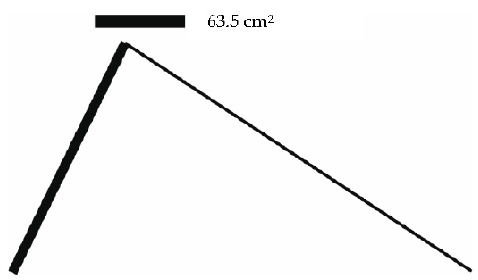
Figure 12. Initial 15 bar structure optimized for load case 2.